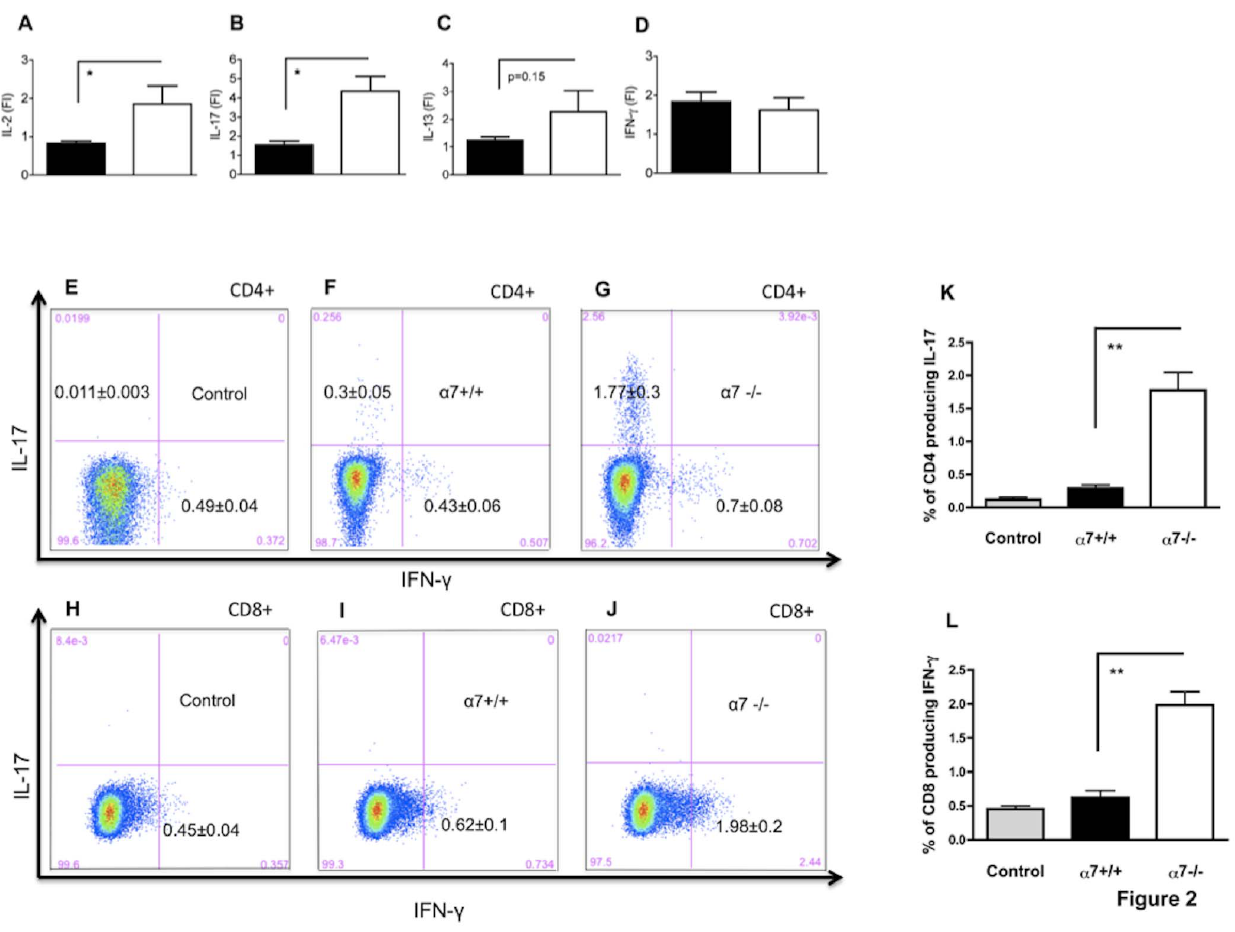
Figure 2. The cholinergic pathway dampens immune responses in the draining lymph node of skin-grafted and imiquimod-treated female recipients. ( A to D ): From A to D , mRNA coding for IL-2, IL-17, IL-13 and IFN- c were quantified by qPCR in draining lymph nodes 30 days after transplantation. Black bars represent wild type donor-recipient combination and white bars the a 7 2 / 2 donor-recipient combination. Results are expressed as fold increase (FI=2 2 DD CT ) of quantities measured in lymph nodes from either ungrafted a 7 + / + or a 7 2 / 2 mice, n=4 to 8 mice per group. (*): p , 0.05 compared with wild type a 7 + / + donor-recipient combination. ( E to G ): Intracellular IL-17 production in CD4 gated T cells after 4 hours of PMA-ionomycin stimulation is shown in control a 7 + / + ungrafted mice ( E ), wild type donor-recipient combination ( F ) and a 7 2 / 2 donor- recipient combinations ( G ). ( H to J ): Intracellular IFN- c production in CD8 gated T cells after 4 hours of PMA-ionomycin stimulation is shown in control a 7 + / + ungrafted mice ( H ), in wild type donor-recipient combination ( I ) and a 7 2 / 2 donor-recipient combinations ( J ). ( K,L ): Bars summarize the percentages of IL-17 + CD4 T cells ( K ) and IFN- c + CD8 T cells ( L ) in either the wild type (black bars) or the a 7 2 / 2 (white bars) donor-recipient combination. Controls have been harvested from a 7 + / + ungrafted mice (grey bars). n=4 to 8 mice/group. No difference regarding IL-17 (Supplementary figure 1) or IFN- c production has been observed between a 7 + / + and a 7 2 / 2 ungrafted controls. (**): p , 0.01 a 7 2 / 2 compared to a 7 + / + donor-recipient